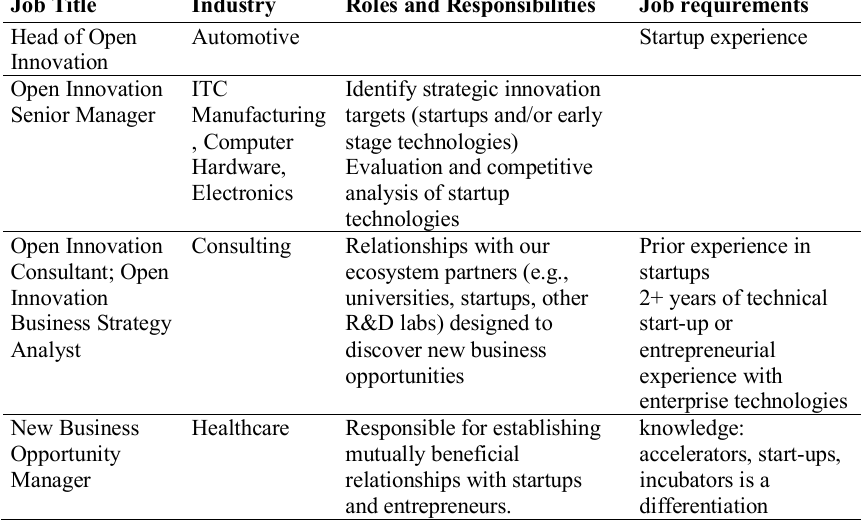
Table 4. List of job titles in 2016 emphasizing start-up experience and entrepreneurial